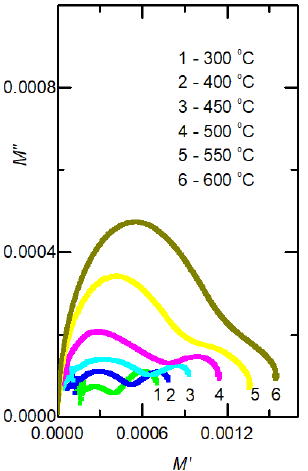
Fig. 12 Complex modulus spectra ( M" vs. M' ) of NBT ceramics at various